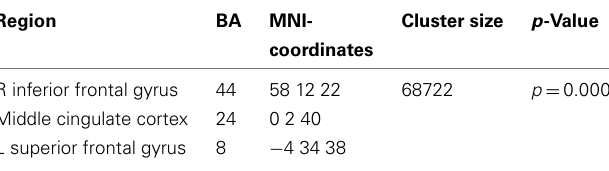
Table 1 | Local maxima of sources showing a power increase (delta/theta band) for preparation for overt reading vs. baseline.